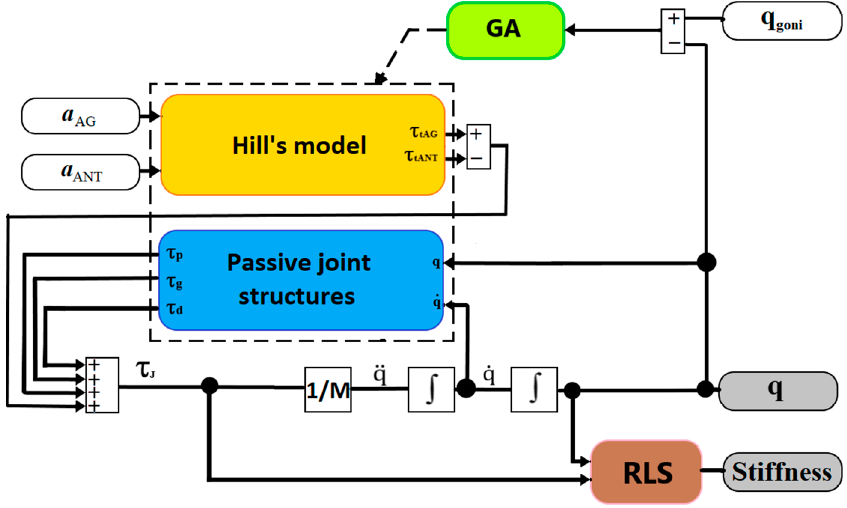
Figure 3. A block diagram of the joint stiffness estimation.